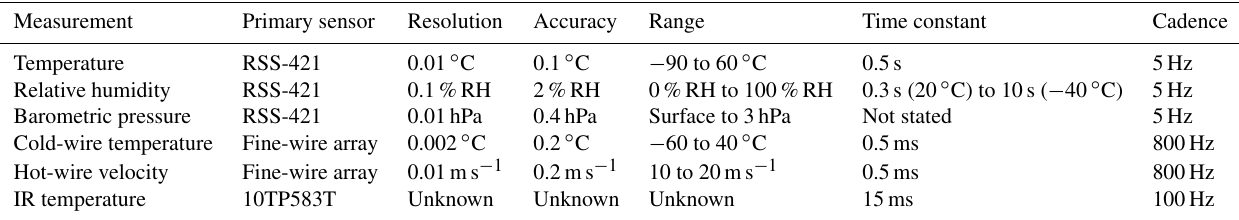
Table 1. DH2 scientific payload. Fine-wire array specifications are from Doddi et al. (2022). Measurement